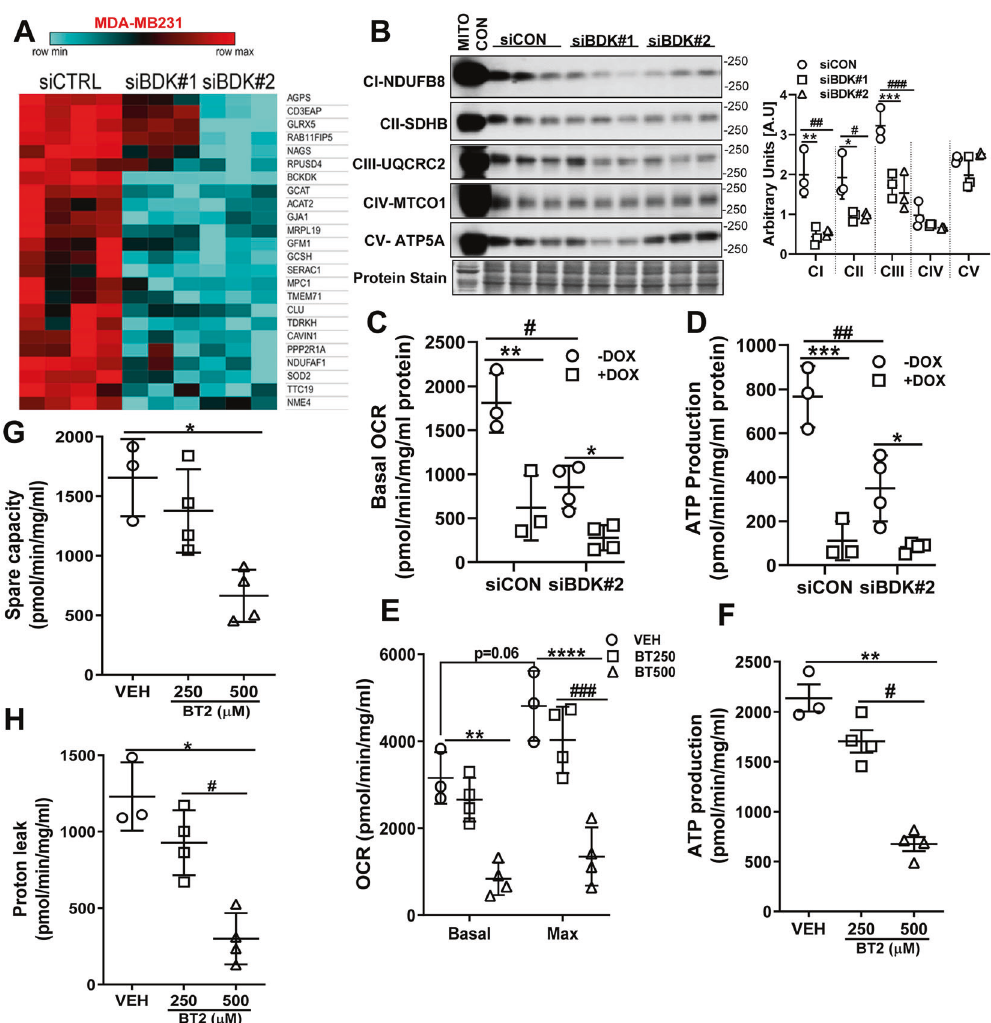
Fig. 5 BCKDK inactivation suppresses mitochondrial function and complex protein expression. A Heatmap for genes involved in mitochondrial biogenesis, structure, and function signi fi cantly differentially regulated by BCKDK knockdown. B Immunoblot and densitometric quanti fi cation of complex I – V proteins in MDA-MB231 whole cell lysates transfected with siCON, siBDK#1, or siBDK#2 for 72 h. Data presented as mean ± S.D. Statistical analysis was performed using a two-way ANOVA followed by a Tukey ’ s multiple comparison test; * p < 0.05, ** p < 0.01, **** p < 0.0001 as indicated. C – H Mitochondrial function measured in BCKDK depleted MDA-MB231 cells using extracellular fl ux analyzer in the presence of 25 mM glucose. C Basal OCR, D ATP production measured in MDA-MB231 cells transfected with siCON or siBDK#2. E Basal and maximal OCR, F ATP production, G spare capacity, and H proton leak measured in MDA-MB231 cells treated with 250 or 500 µM BT2 for 20 h. B , *siCON vs siBDK#1, #siCON vs siBDK#2; C – D , *within groups (DMSO vs DOX), #between groups (siCON